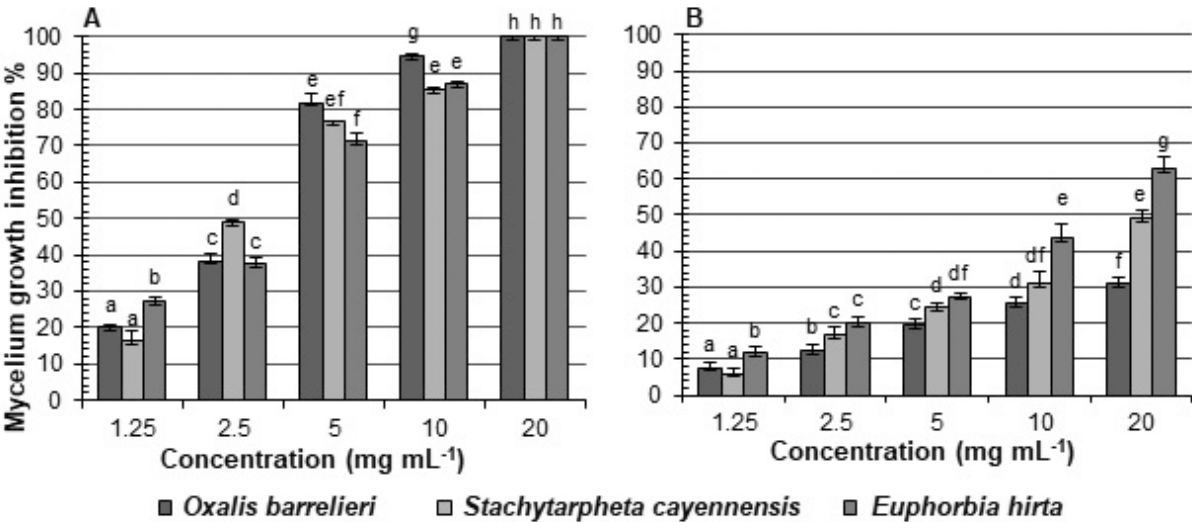
Figure 3. Mycelium growth inhibition (%) of Fusarium oxysporum f. sp. vasinfectum at 1.25, 2.50, 5, 10 or 20 mg mL -1 concentrations of the ethanol extracts (A) or water extracts (B) for extracts from three different plant species . Data are means ± standard deviation from three experiments, each with five replicates. At each extract concentration, the means accompanied by different letters are significantly different, according to ANOVA paired with Tukey’s tests ( P ≤ 0.05).